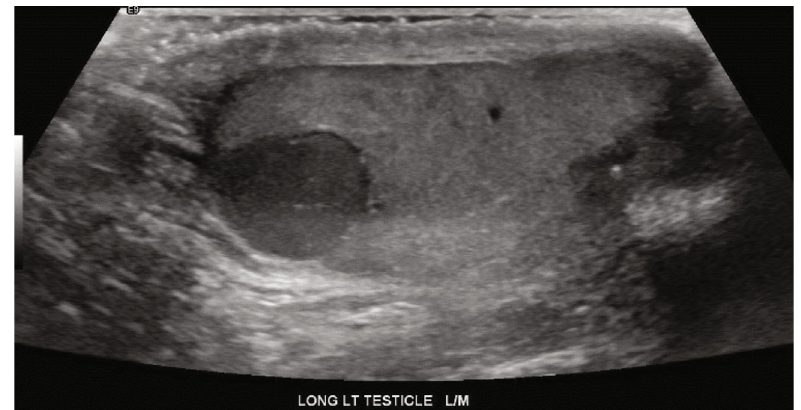
Figure 1: Scrotal ultrasound demonstrating left testis mass.